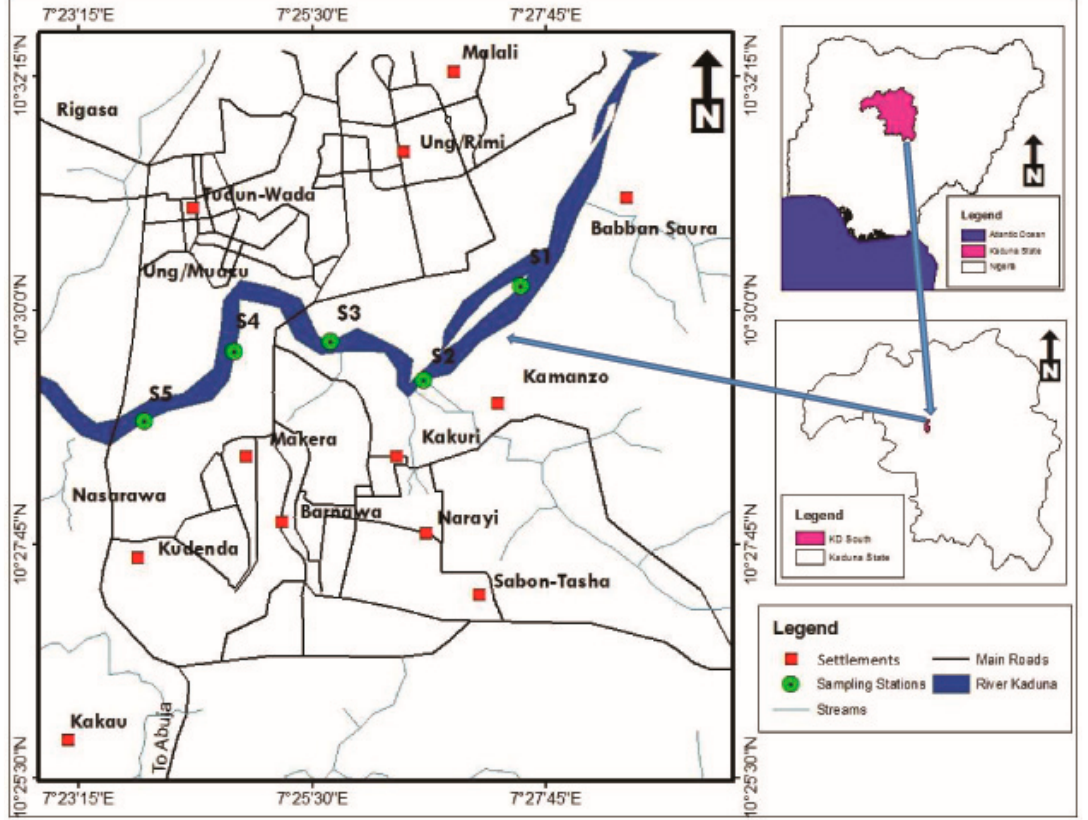
Figure 1. Map of River Kaduna Showing Sampling Sites.